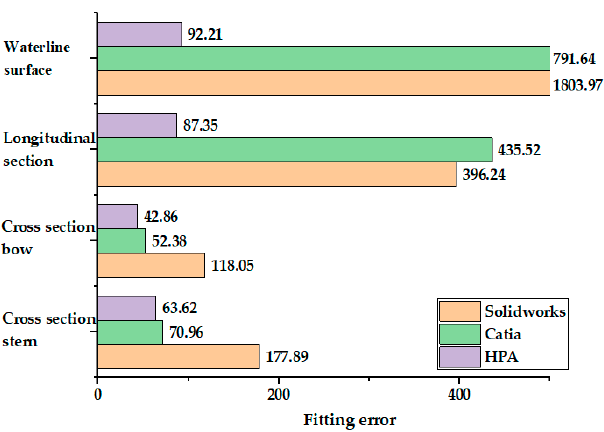
Figure 17. Maximum error of fitting using Solidworks, Catia and HPA at the same number of control points.